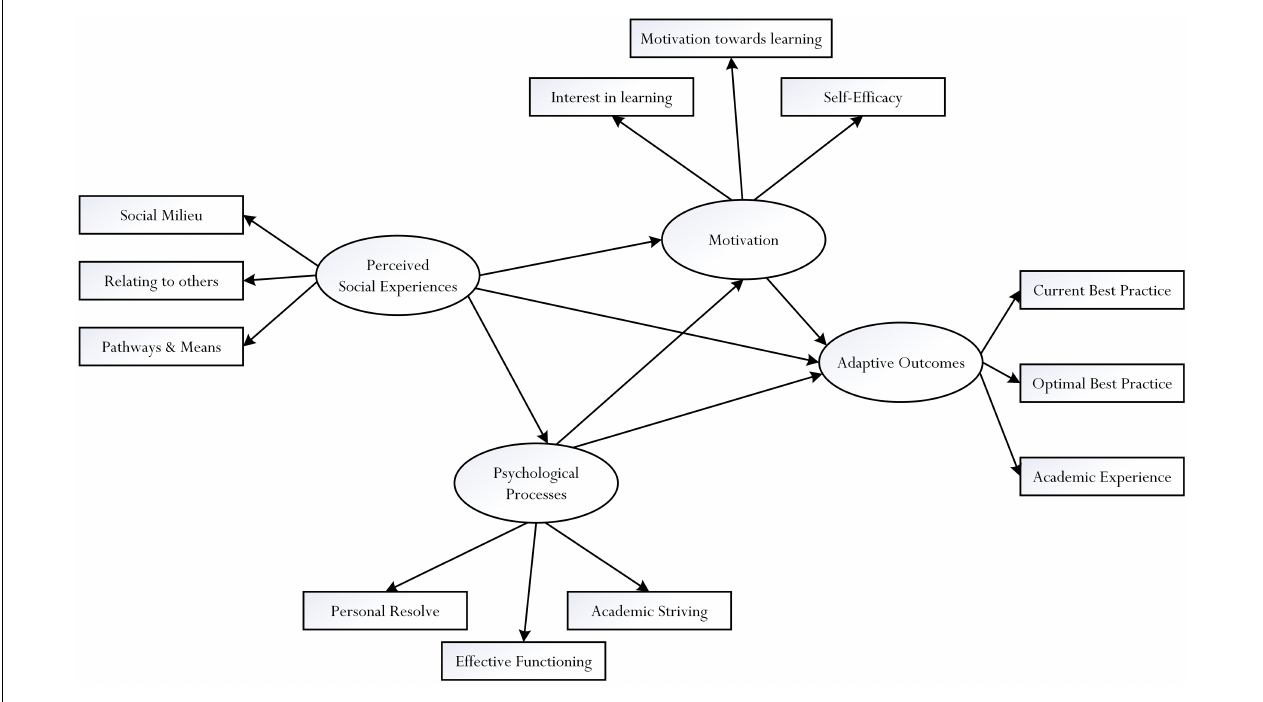
FIGURE 1 | Conceptual model for